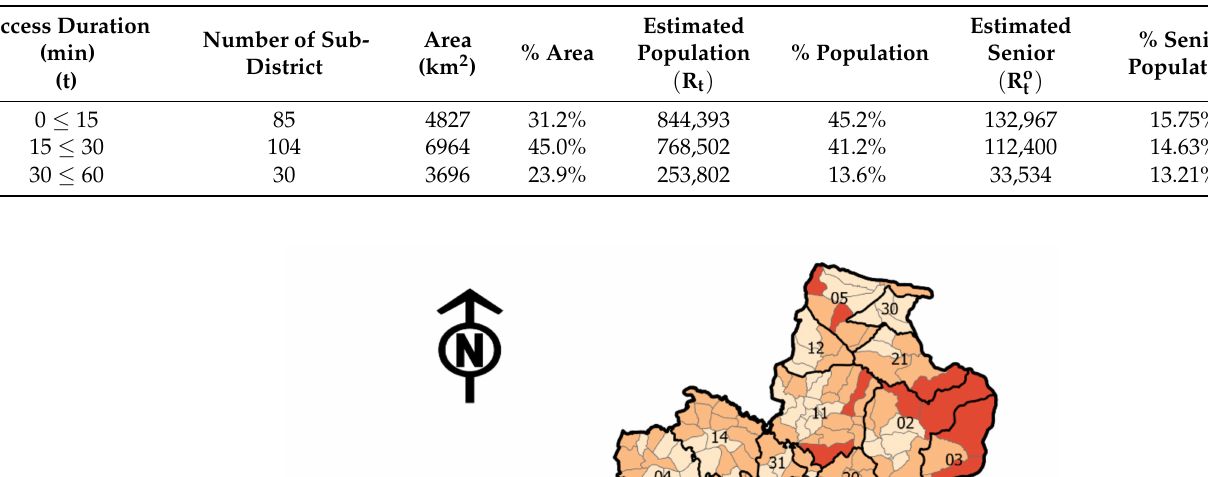
Table 3. Accessibility based on the estimated area and population to reach the nearest healthcare provide within a certain time period.